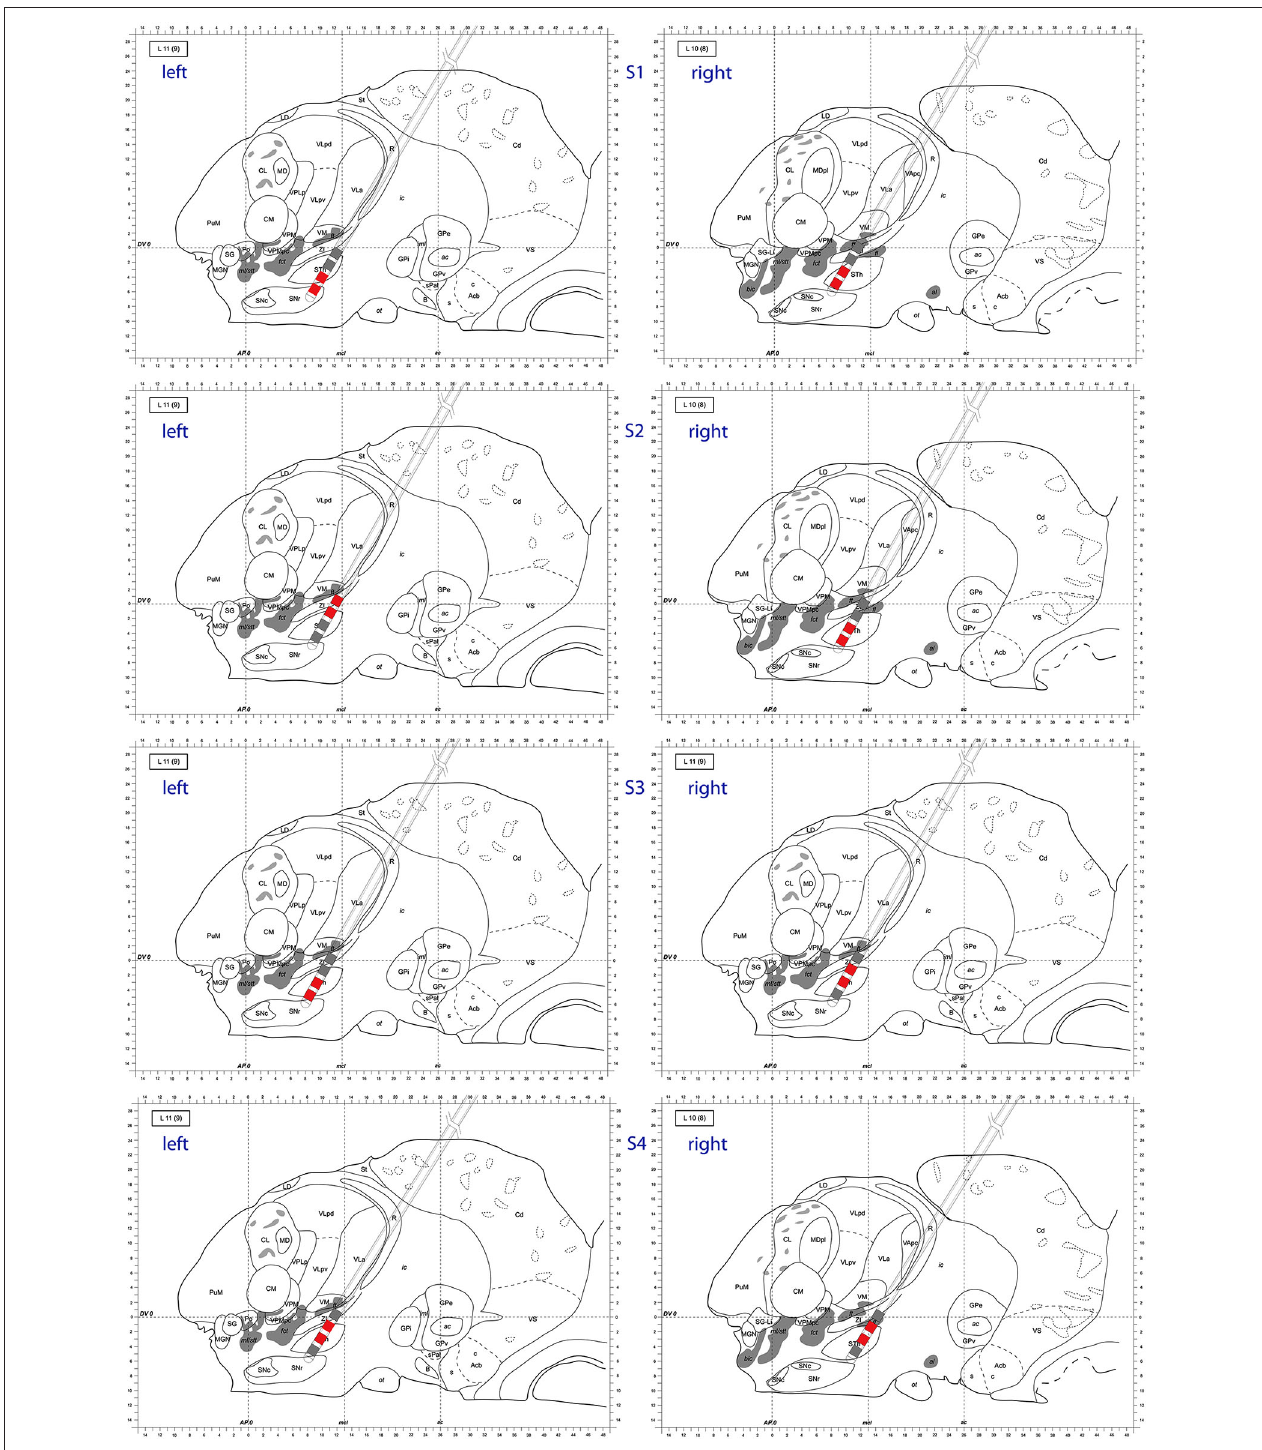
FIGURE 8 | Atlas representation demonstrating DBS lead position for each subject . Bipolar montages with cross hemispheric phase synchrony are colored in red. The left column corresponds to left hemisphere, right column to right hemisphere. Sagittal atlas adopted from Morel (2007) with permission.